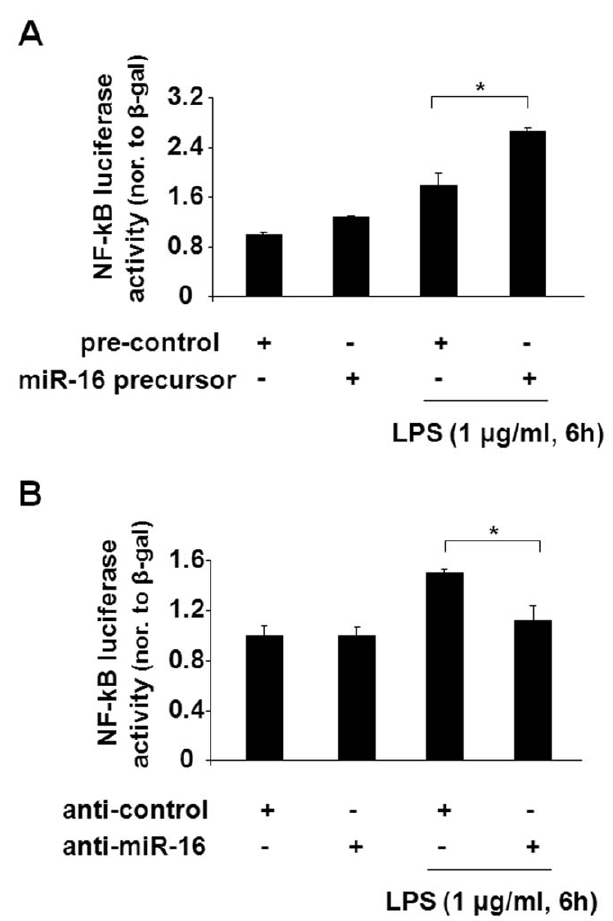
Figure 4. miR-16 enhances NF- k B-regulated transcriptional activity induced by LPS in H69 cells. H69 cells were co-transfected with the NF- k B-driven IL-8 luciferase reporter construct with the miR-16 precursor (A) or anti-miR-16 (B) for 24 h, followed by exposure to LPS for an additional 6 h. Luciferase activity was measured and normalized to the b -gal control. Data shown are the average of three independent experiments. *, p , 0.05 t -test vs. the controls. doi:10.1371/journal.pone.0030772.g004 SMRT protein in H69 and U937 cells (Fig. 6D). Transfection of cells with the non-specific anti-miR control showed no effects on LPS-induced downregulation of SMRT protein (Fig. 6D). The above data suggest that miR-16 upregulation is required for LPS- induced downregulation of SMRT protein in H69 and U937 cells.